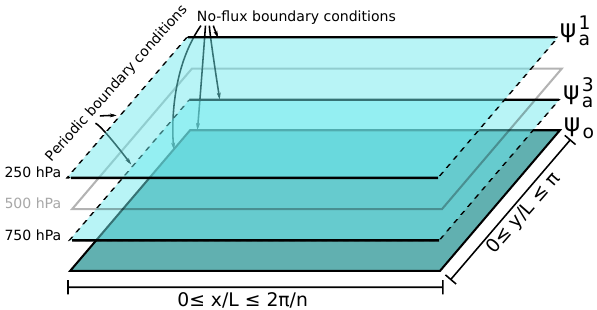
Figure 1. MAOOAM model schematic